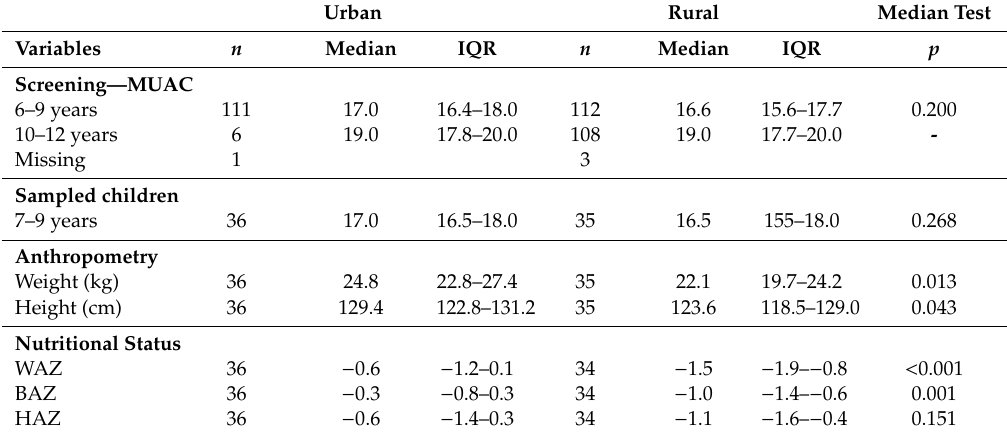
Table 4. Median and IQR of anthropometry and nutritional status of